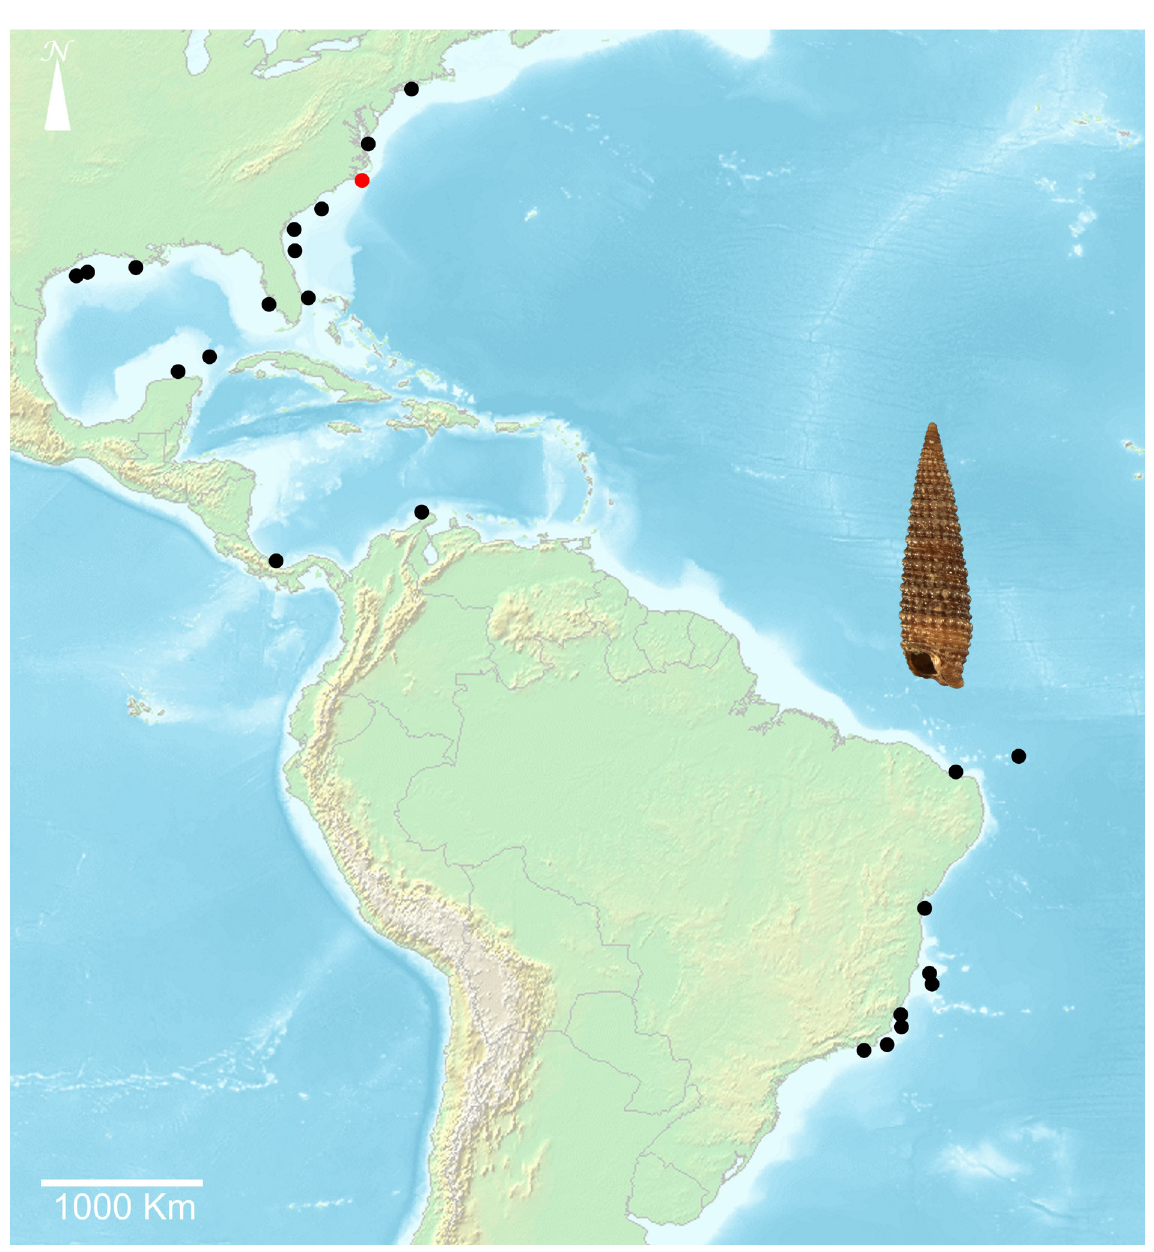
Fig. 29. Distribution map of Cheirodonta dupliniana (Olsson, 1916); red circle = type